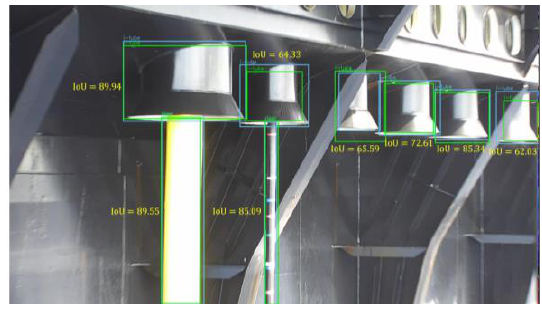
Figure 9. Quantitative results